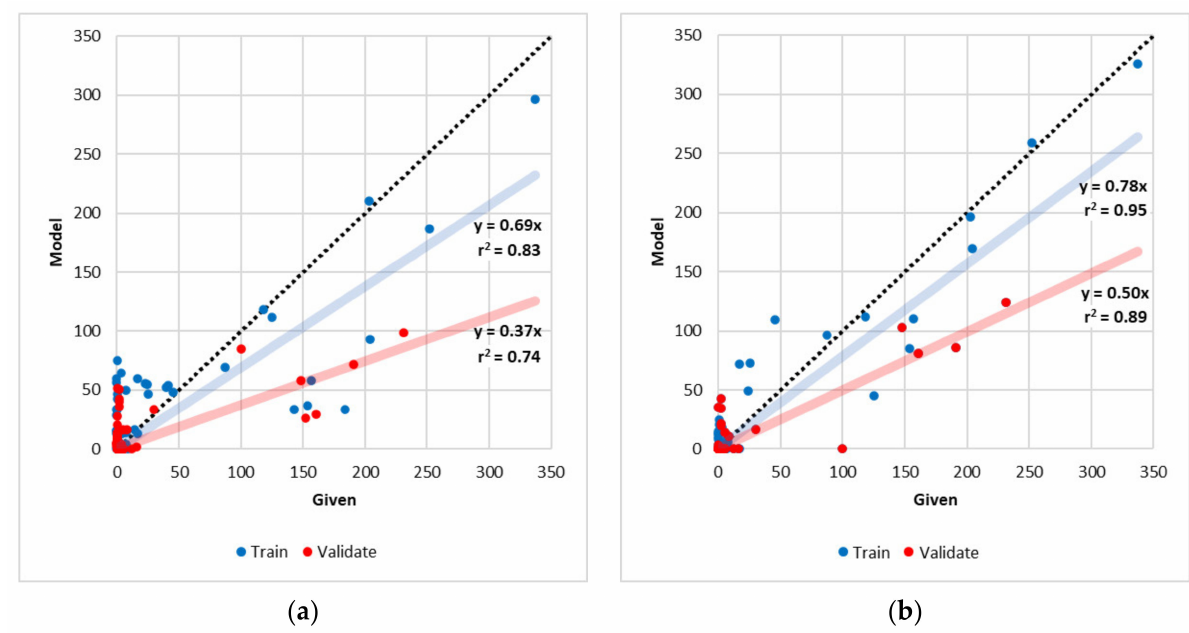
Figure 17. Plot of given and modelled Fe 3+ values based on Sentinel-2 ( a ) Level-1C TOA and ( b ) Level-2A BOA products.